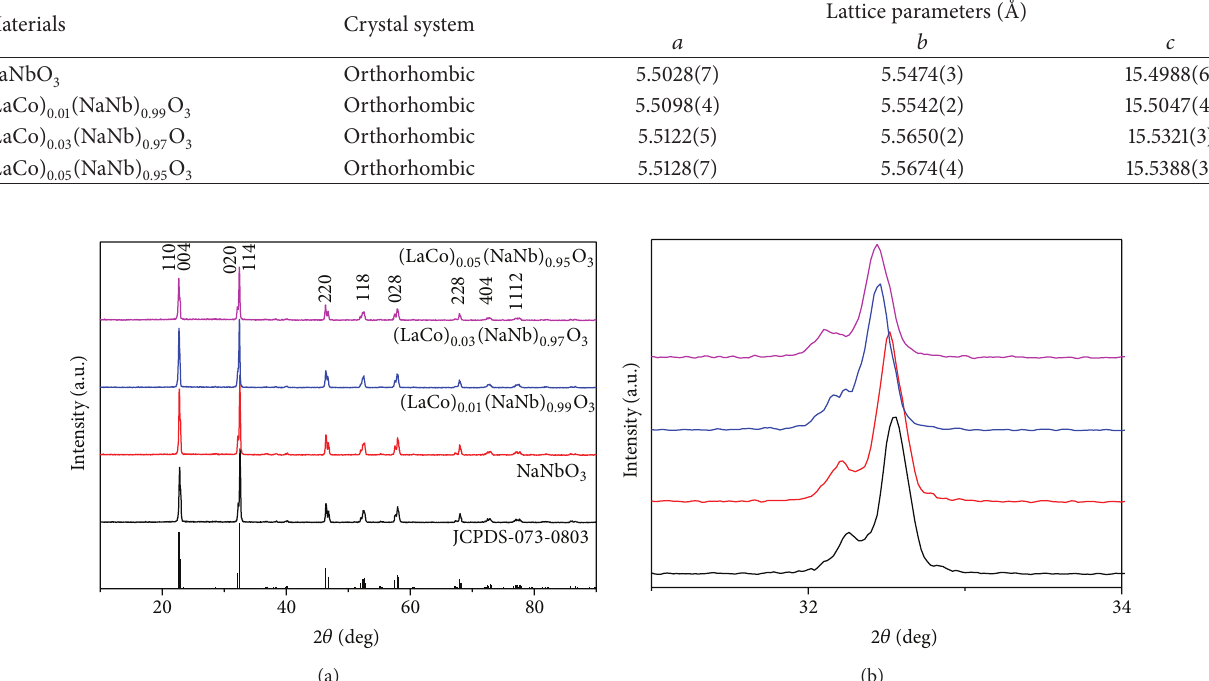
Figure 1: (a) XRD patterns of the as-prepared NaNbO 3 and La, Co codoped NaNbO 3 compared with the standard NaNbO 3 XRD pattern. (b) The enlarged XRD patterns of the highest diffraction peak of NaNbO 3 .